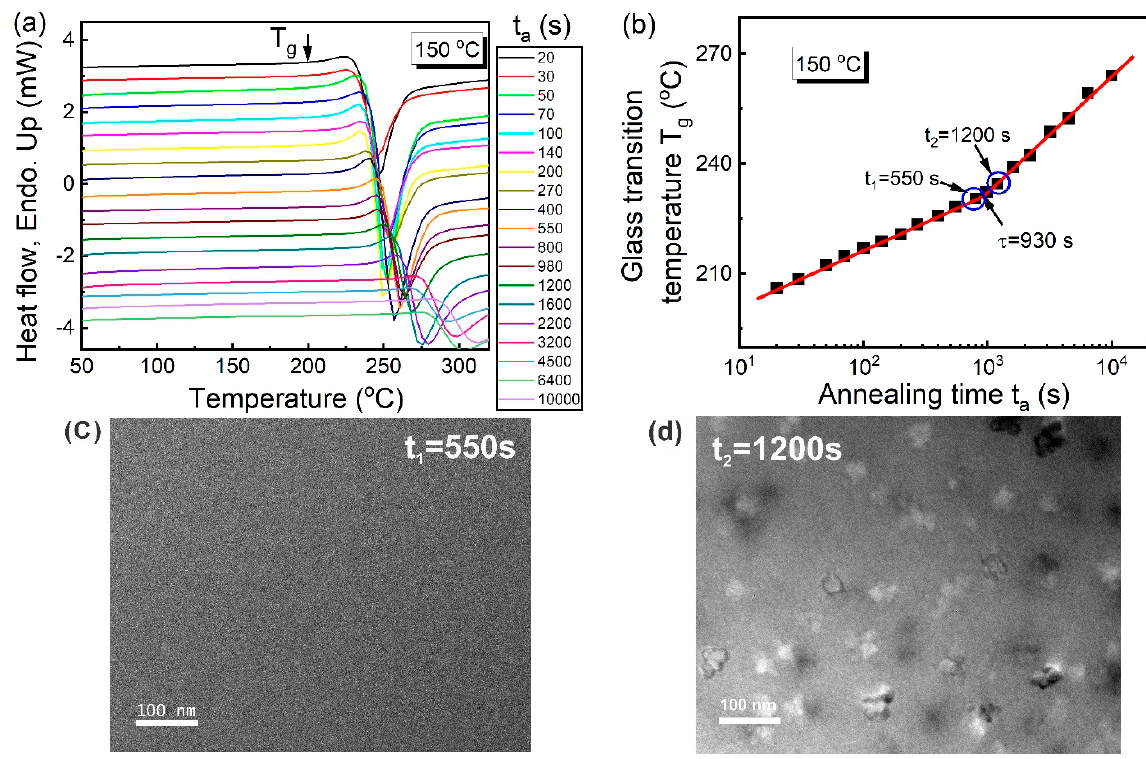
Figure 3. ( a ) A series of Flash DSC heat flow curves corresponding to different annealing times ranging t a from 20 to 10,000 s at 150 °C for Al 92 Sm 8 MG; ( b ) plot of T g and t a at 150 °C ( t 1 and t 2 are two selected annealing times before and after the break point of 930 s); ( c ) TEM image for annealed sample corresponding to the annealing time of t 1 ; and ( d ) TEM image for annealed sample corresponding to the annealing time of t 2 .